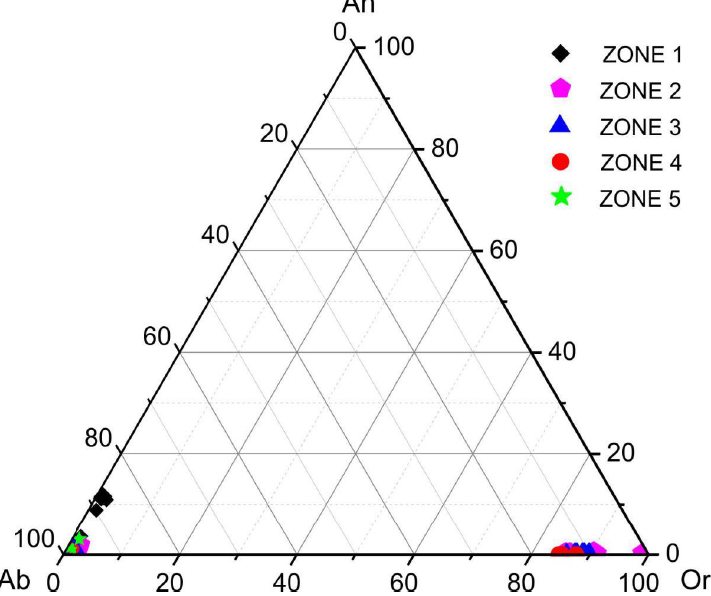
Figure 9. The ternary diagram of Ab-An-Or composition of alkali feldspar from five zones of the Yamrang Pegmatite.